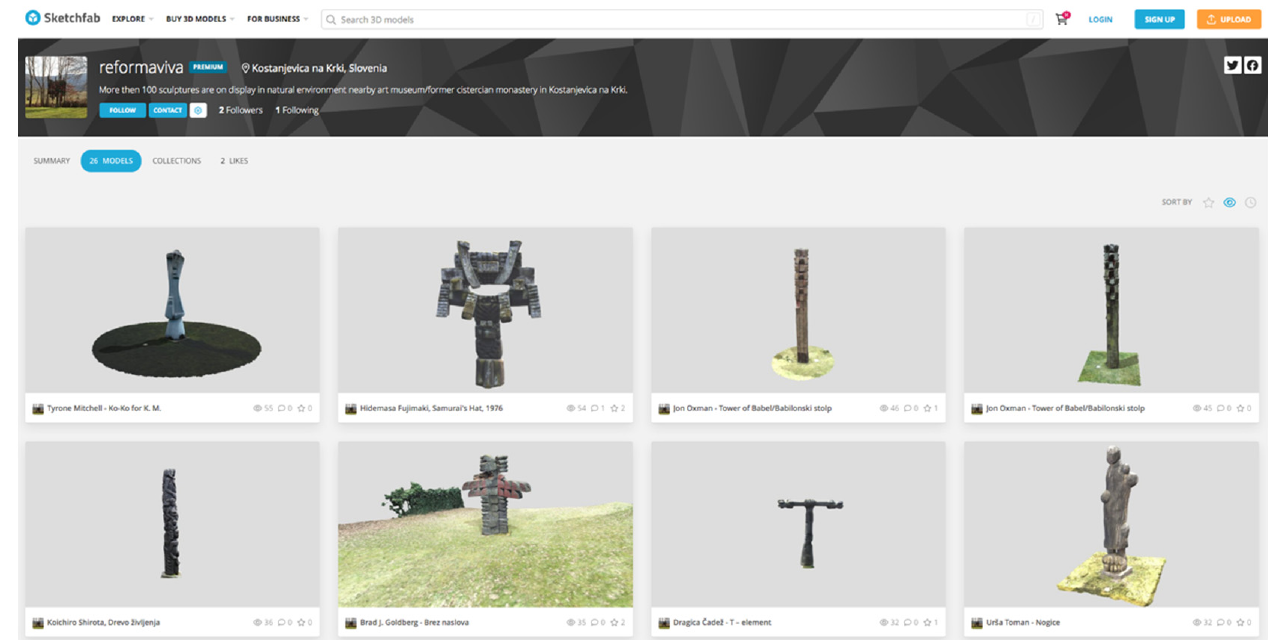
Figure 7. Three-dimensional presentations of sculptures in 3D viewer Sketchfab.